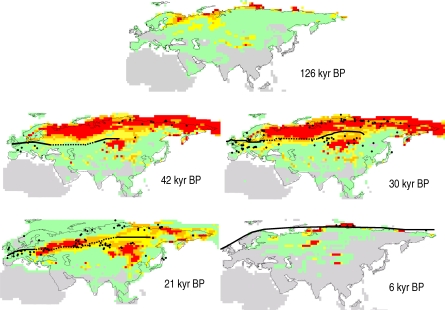
Maps of Projected Climatic Suitability for the Woolly Mammoths in the Late Pleistocene and HoloceneSuitability scores are divided into four colour-scale classes (quartiles 1 [more suitable] to 4 [less suitable] of the MD), where increasing intensities of red represent increasing suitability of the climate and increasing intensities of green represent decreasing suitability. Black points are the records of mammoth presence for each of the periods. Black lines represent the northern limit of modern humans [59]. Black dotted lines indicate uncertainty in the limit of modern humans.